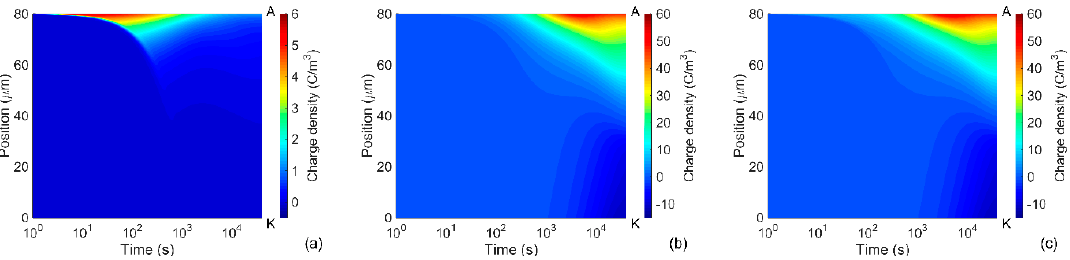
Figure 2. Computed charge density distributions in LDPE at room temperature: ( a ) mobile charges; ( b ) trapped charges; and ( c ) total space charges. Positions of the anode and cathode are indicated by letters A and K, respectively.